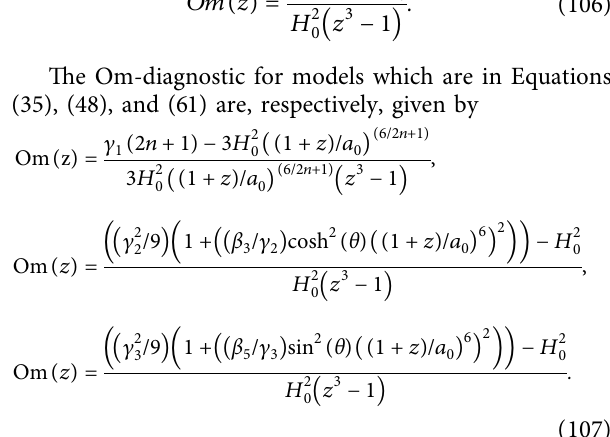
vhde ). versus redshift ( z )